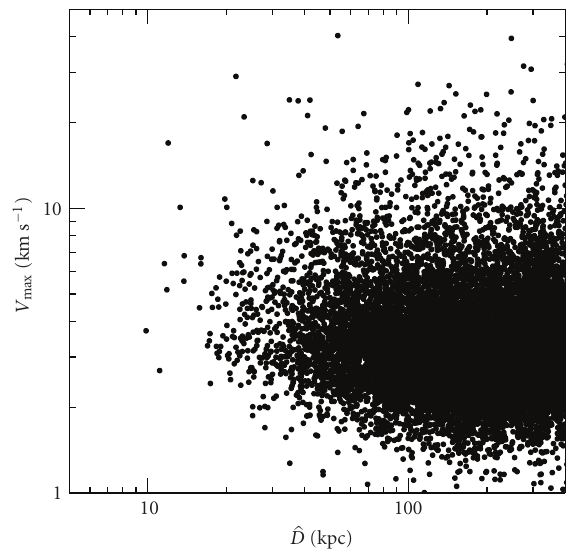
Figure 4: VL2 subhalo V max versus distance to host halo (cid:15) D